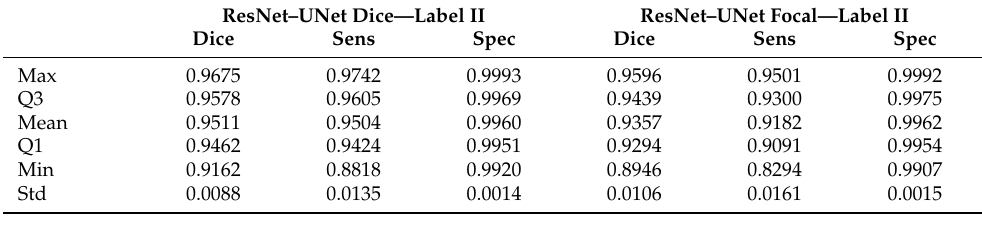
Table 5. Test set results of the ResNet–UNet network trained with Dice or focal loss in phase 2.